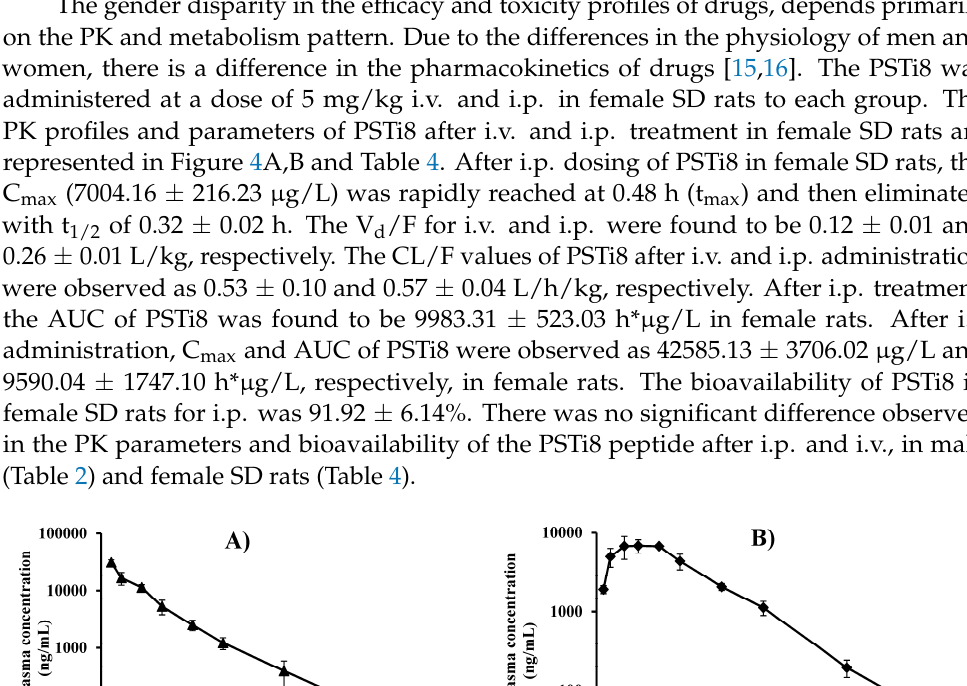
Figure 3. Dose proportionality pharmacokinetic studies of the PSTi8 peptide in male SD rats. Plasma concentration against time profiles of PSTi8 peptide after i.p. administration at 10 and 20 mg/kg to each group. Data are represented in n = 6 with the mean ± SD. Table 3. Pharmacokinetic parameters of the PSTi8 peptide after i.p. administration at two doses of 10 and 20 mg/kg in male SD rats. Data are represented as the mean ± SD with n = 6.